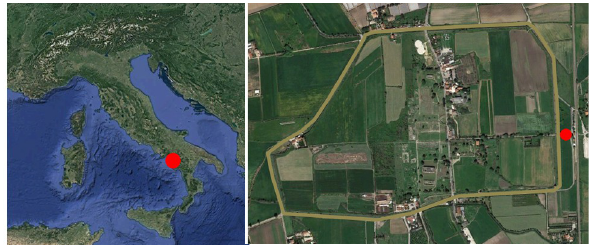
Figure 1. Archaeological site of Paestum (South-Italy)